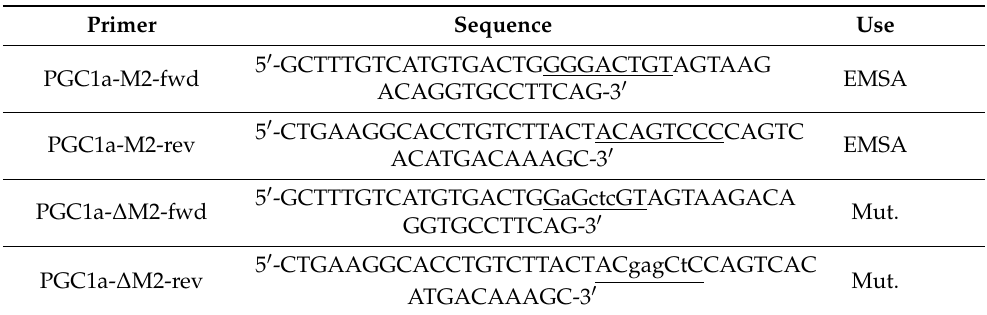
Table 1. Primers used for EMSA and mutagenesis (Mut.). The p65 binding site is underlined, and mutated nucleotides are in